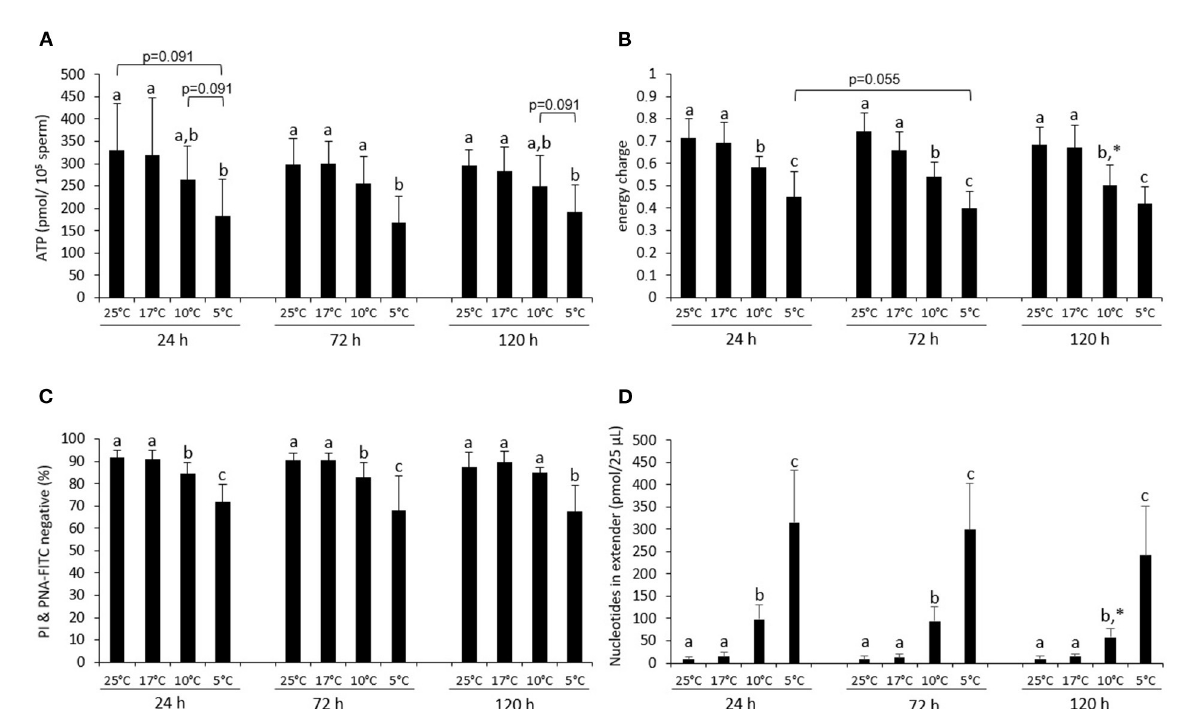
FIGURE1 Energy status and sperm viability during storage at different temperatures. ATP content (A) , energy charge (B) , percentage viable, acrosome-intact sperm [PI & PNA-FITC negative; (C) ], and sum of nucleotides (ATP + ADP + AMP) in the semen extender (D) of boar semen samples stored at various temperatures in Beltsville Thawing Solution. Samples were analyzed directly at the respective storage temperature or after 15min incubation at RT (PI & PNA-FITC staining). Data are presented as means ± standard deviation ( n = 7 boars). (a–c) Different letters indicate significant differences between storage temperatures within a given day ( P < 0.05). An asterisk ( * ) indicates a significant difference between values after 72 or 120h storage and the value after 24h storage ( P <